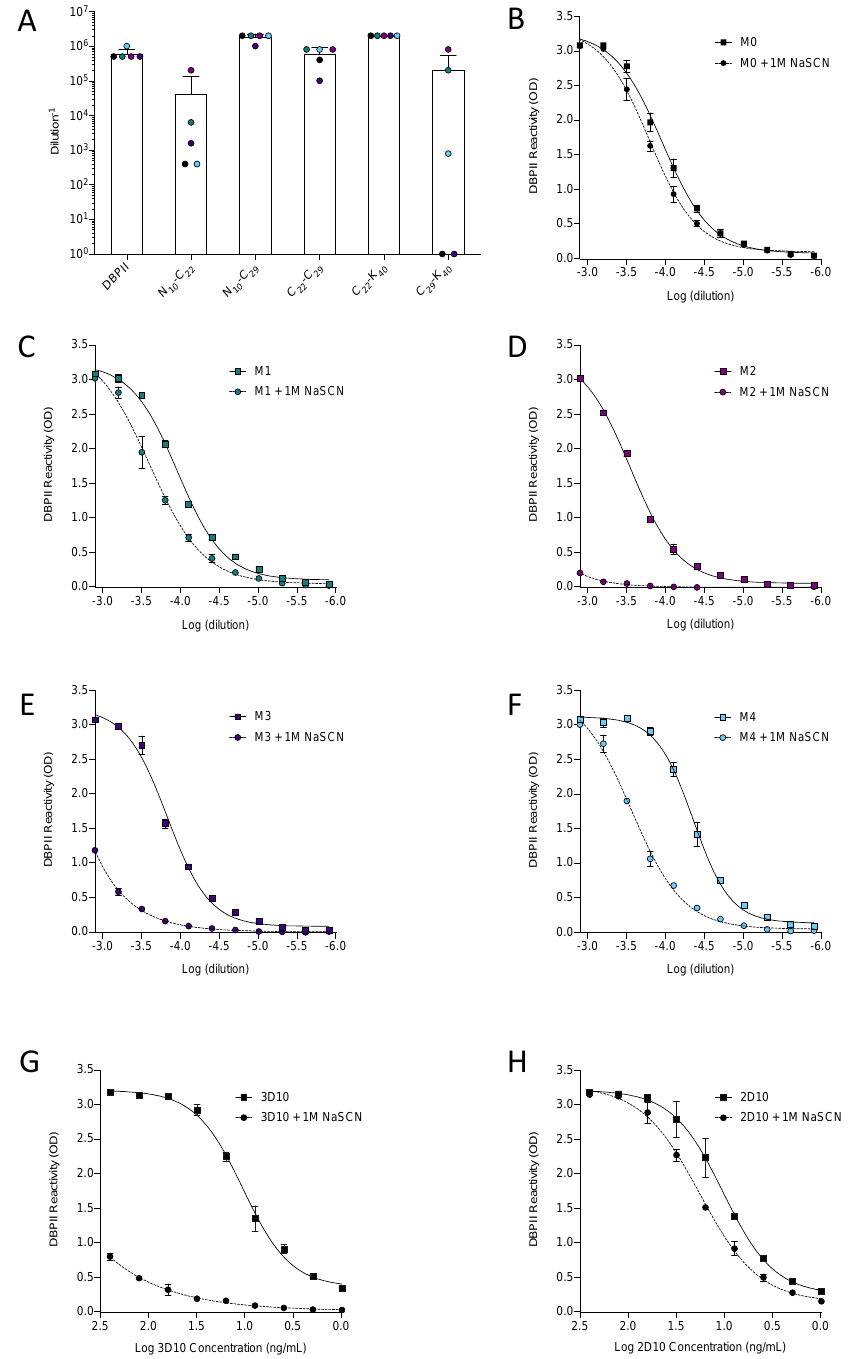
Figure 5. Cross-reactive sera that recognized VAR2CSA had low avidity against DBPII. ( A ) Endpoint titers for the individual mice immunized with SD1 CLIPS -KLH were measured against DBPII and the synthetic peptides spanning the SD1 region. Endpoint titers were calculated relative to the mean OD of the matching preimmune serum plus two standard deviations. Data from each individual mouse (M#) are represented by a unique color. ( B – F ) The avidity of the individual serum samples for DBPII was determined by titrating against DBPII with and without the addition of 1 M NaSCN. ( G – H ) The avidity of 3D10 and 2D10 (a non-cross-reactive DBPII monoclonal antibody) against DBPII was determined by titrating the monoclonal antibodies against DBPII with or without the addition of 1 M NaSCN. Data are mean ± SD.